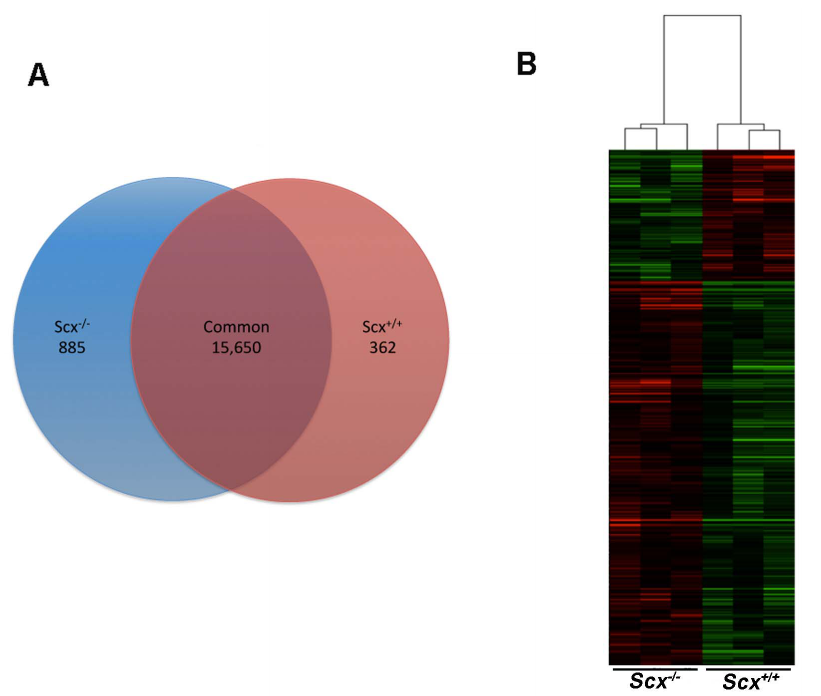
Figure 1. Loss of Scx function in remodeling murine heart valves at E15.5 leads to distinct transcriptome profiles. (A) Venn diagram to show the number of detectable protein-coding and non-protein coding mRNAs that were unique and common to Scx + / + and Scx -/- samples. (B) Heat map to show hierarchical clustering of differentially expressed genes ( . 1.5-fold change, p , 0.05) in Scx + / + and Scx -/- samples. doi:10.1371/journal.pone.0101425.g001 PLOS ONE |